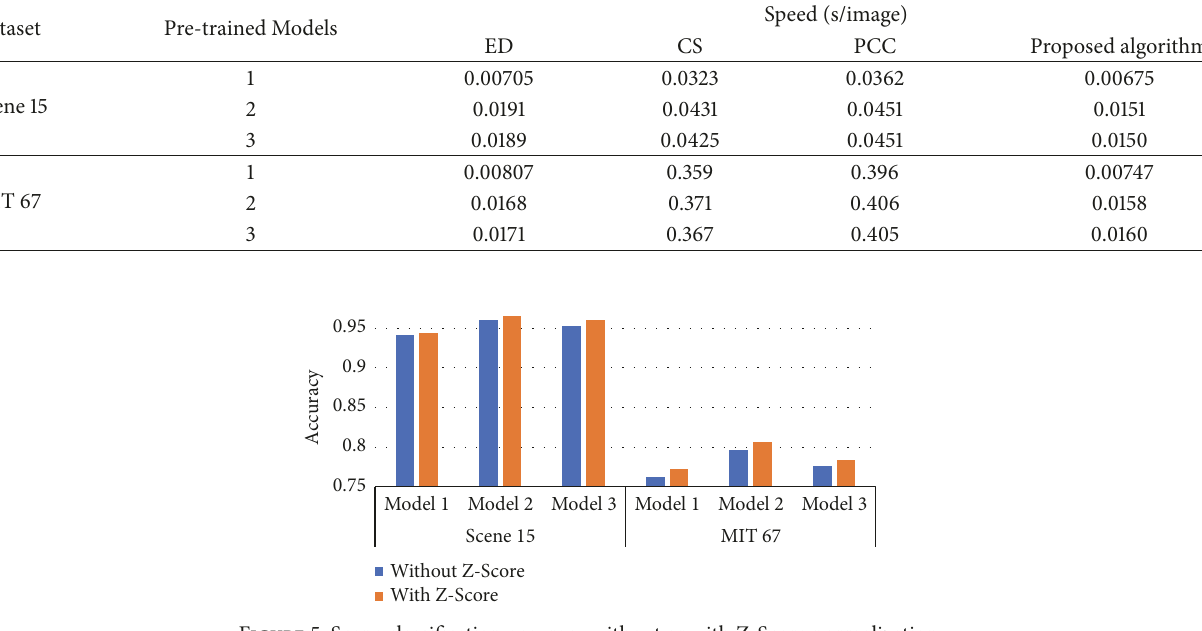
Figure 5: Scene classification accuracy without or with Z-Score